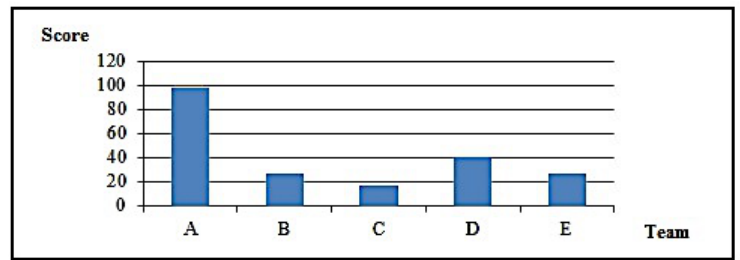
Figure 9. Final scores, organized by